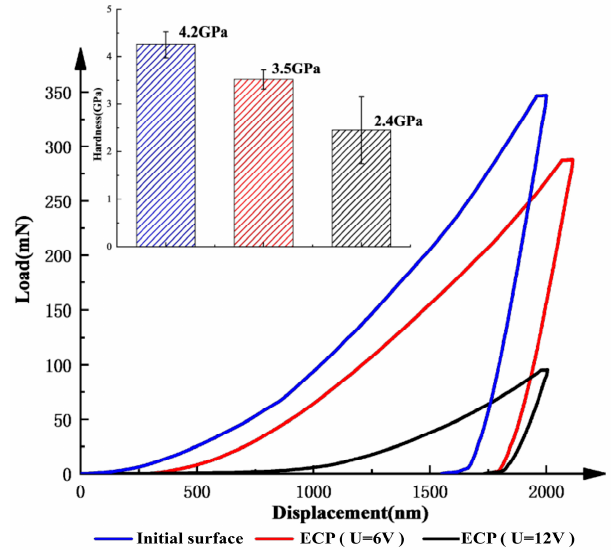
Figure 7. Measured load–displacement curves and calculated hardness values.